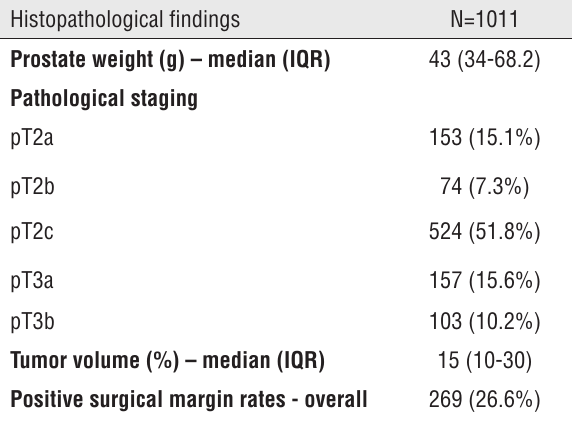
Table 5 – Histopathological findings. Histopathological